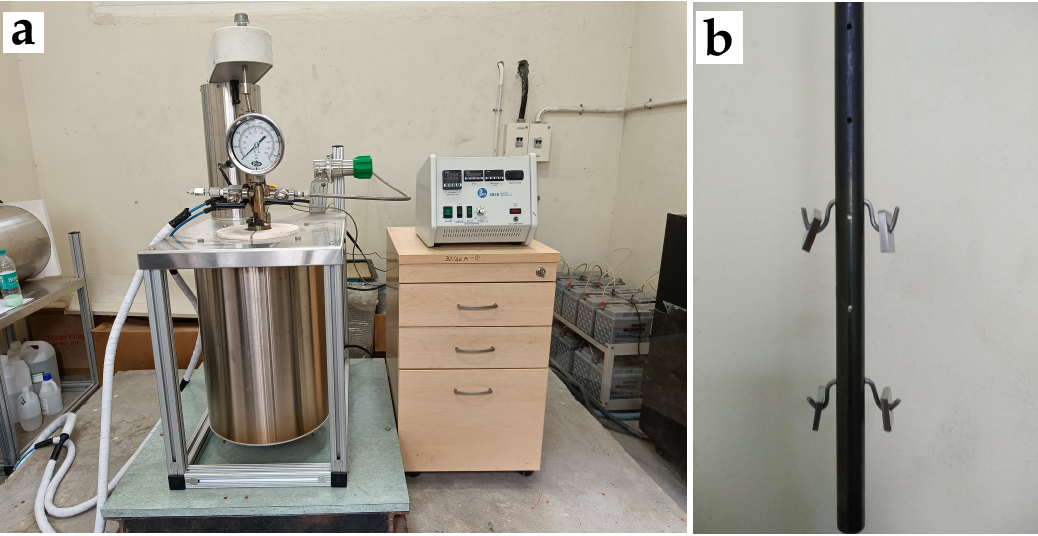
Figure 4. ( a ) steam oxidation experimental test facility; ( b ) sample holder with